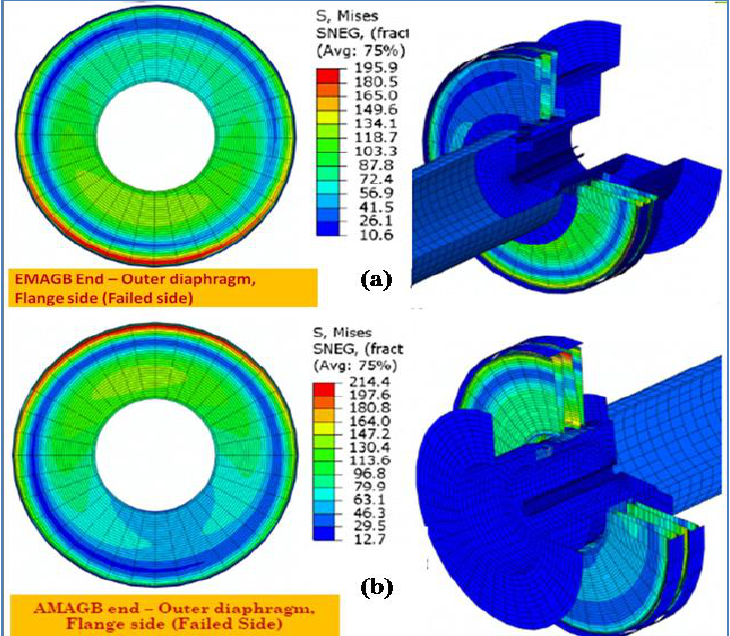
Fig. 10: Stress patterns developed on the failed diaphragms of the PTO shafts under combined actions of misalignments, peak operating torque and centrifugal forces - (a) EMAGB (engine) end outer failed diaphragms, (b) AMAGB end failed outer